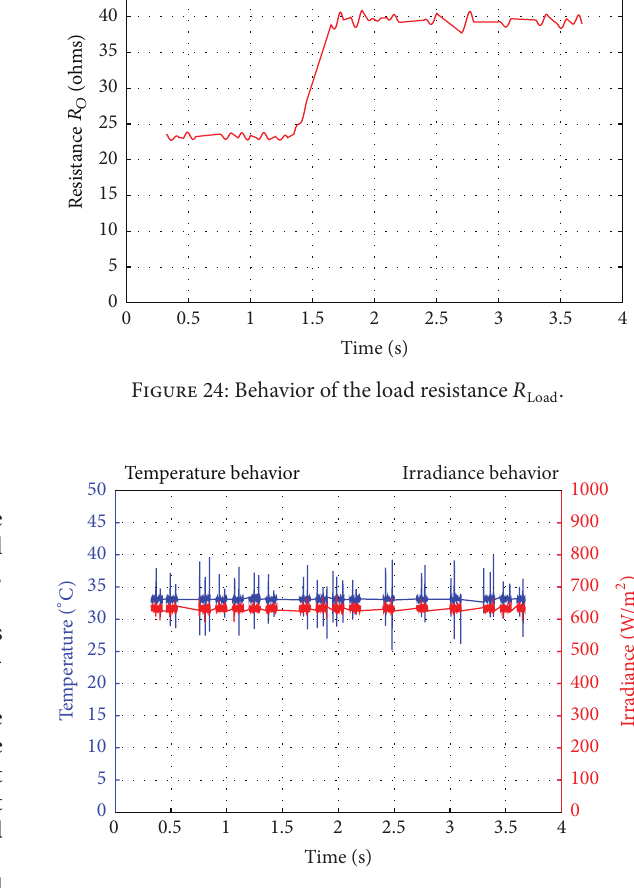
Figure 25: Behavior of temperature (𝑇) and irradiance (𝐺)